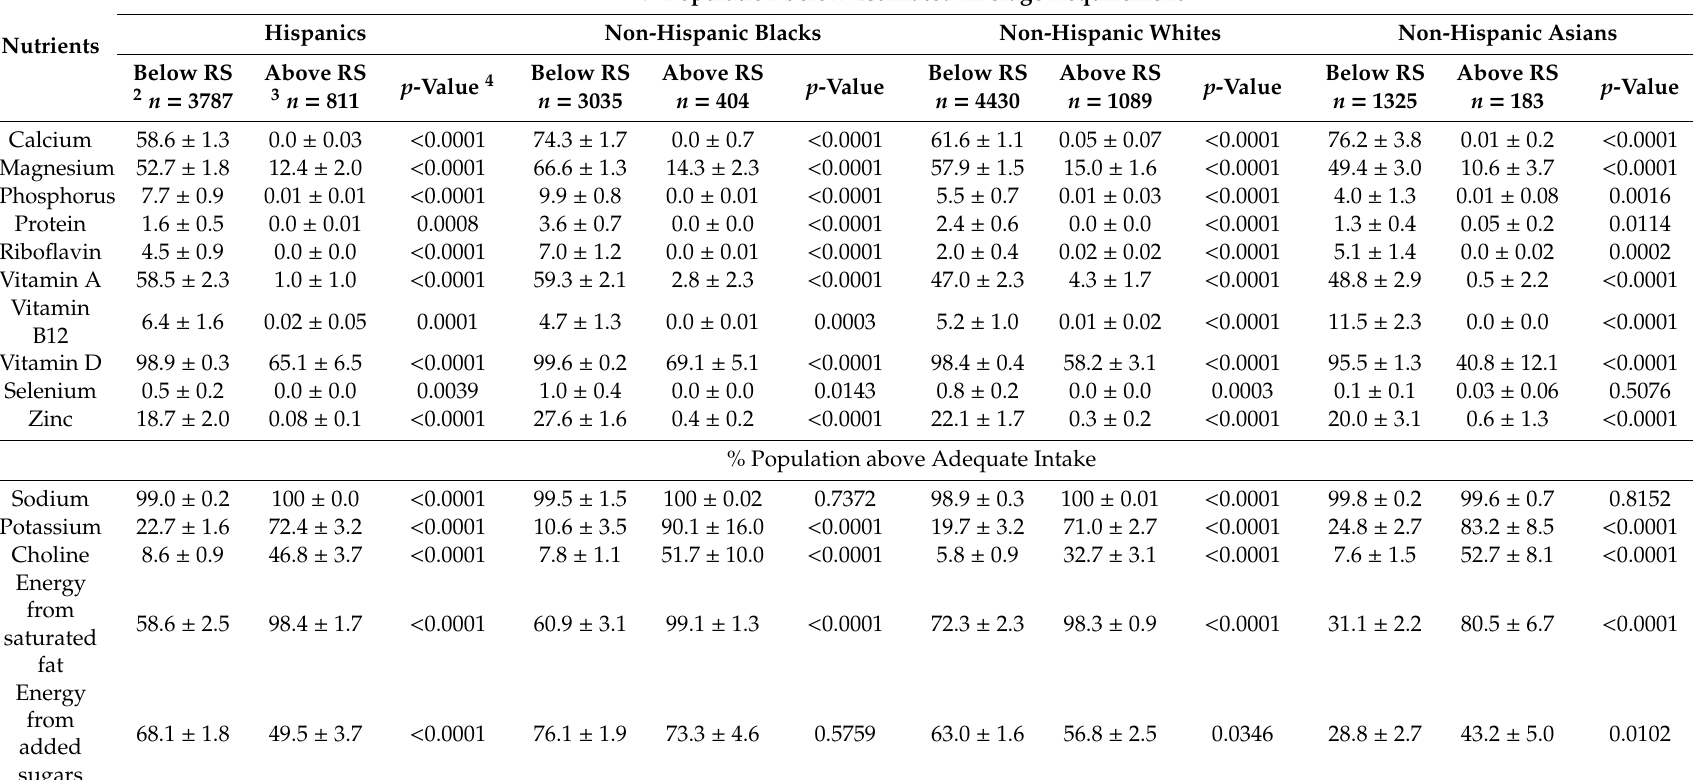
Table 7. Percent U.S. population (by ethnicity / race) below the Estimated Average Requirement or Above Adequate Intake among those consuming above recommended daily servings of dairy (Above RS) and below recommended daily servings of dairy (Below RS), ages 2 + , in the National Health and Nutrition Examination Survey 2013–2016 1